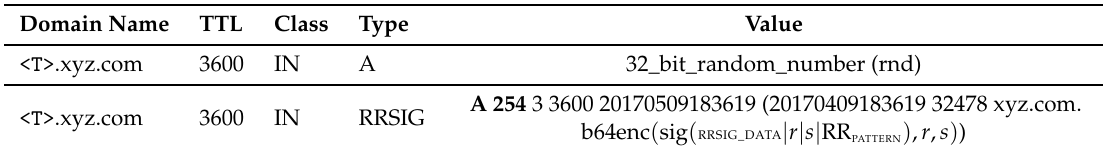
Table 3. Example of signed pattern